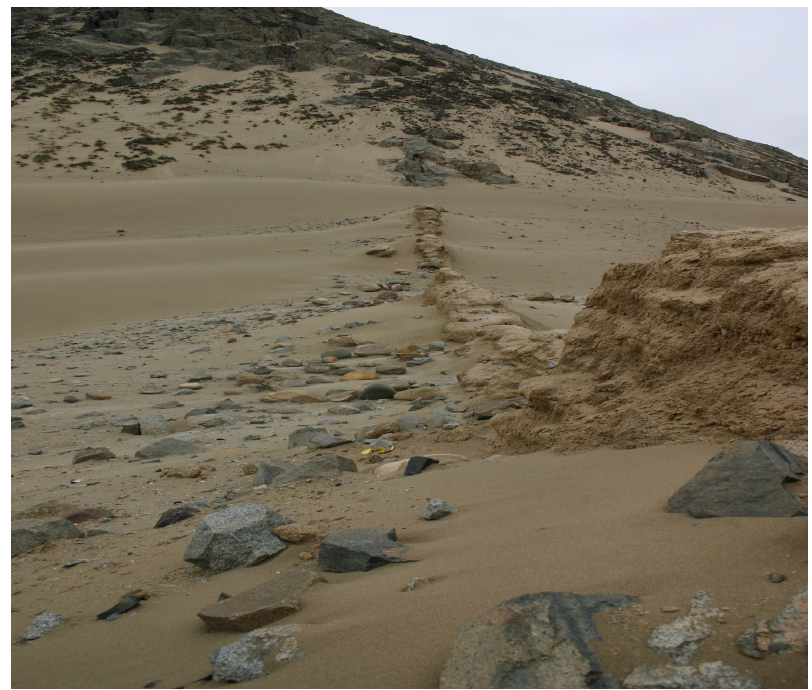
Figure 30. Furthest stone wall aeolian sand barrier. The barrier sequence represents efforts to limit sand inundation into urban Caral.